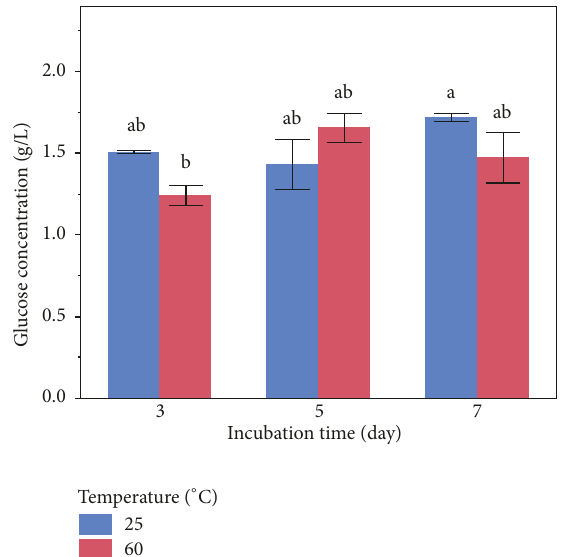
Figure 1: Effects of temperature and incubation time on glucose production from pretreated RS after 1h of enzymatic hydrolysis (hydrolysis conditions: 1.5% solid loading, 15FPU and 100XU/g solid, pH 4.8, and 50 ∘ C). Different letters within bars indicate significant differences ( 𝑝 < 0.05 ) between the means of glucose concentrations as analyzed by Tukey’s test of multiple comparisons after ANOVA test. Each bar is the mean value of three experiments ( 𝑛 = 3 ). Error bars represent standard